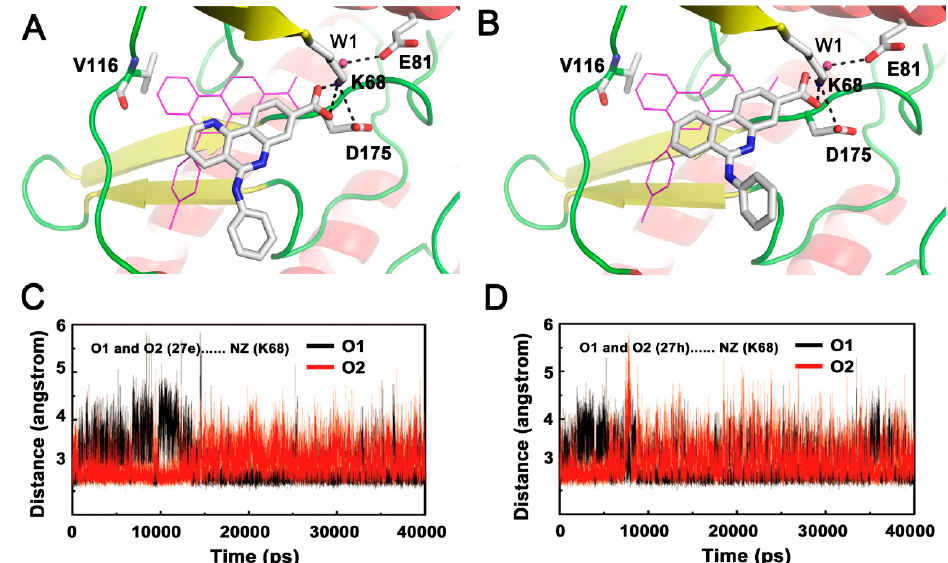
Figure 4. Stable binding mode of compounds ( A ) 27e and ( B ) 27h compared to compound 12 (magenta); Distances between NZ atoms of Lys68 and ( C ) O1 and O2 atoms of compound 27e , ( D ) O1 and O2 atoms of compound 27h .